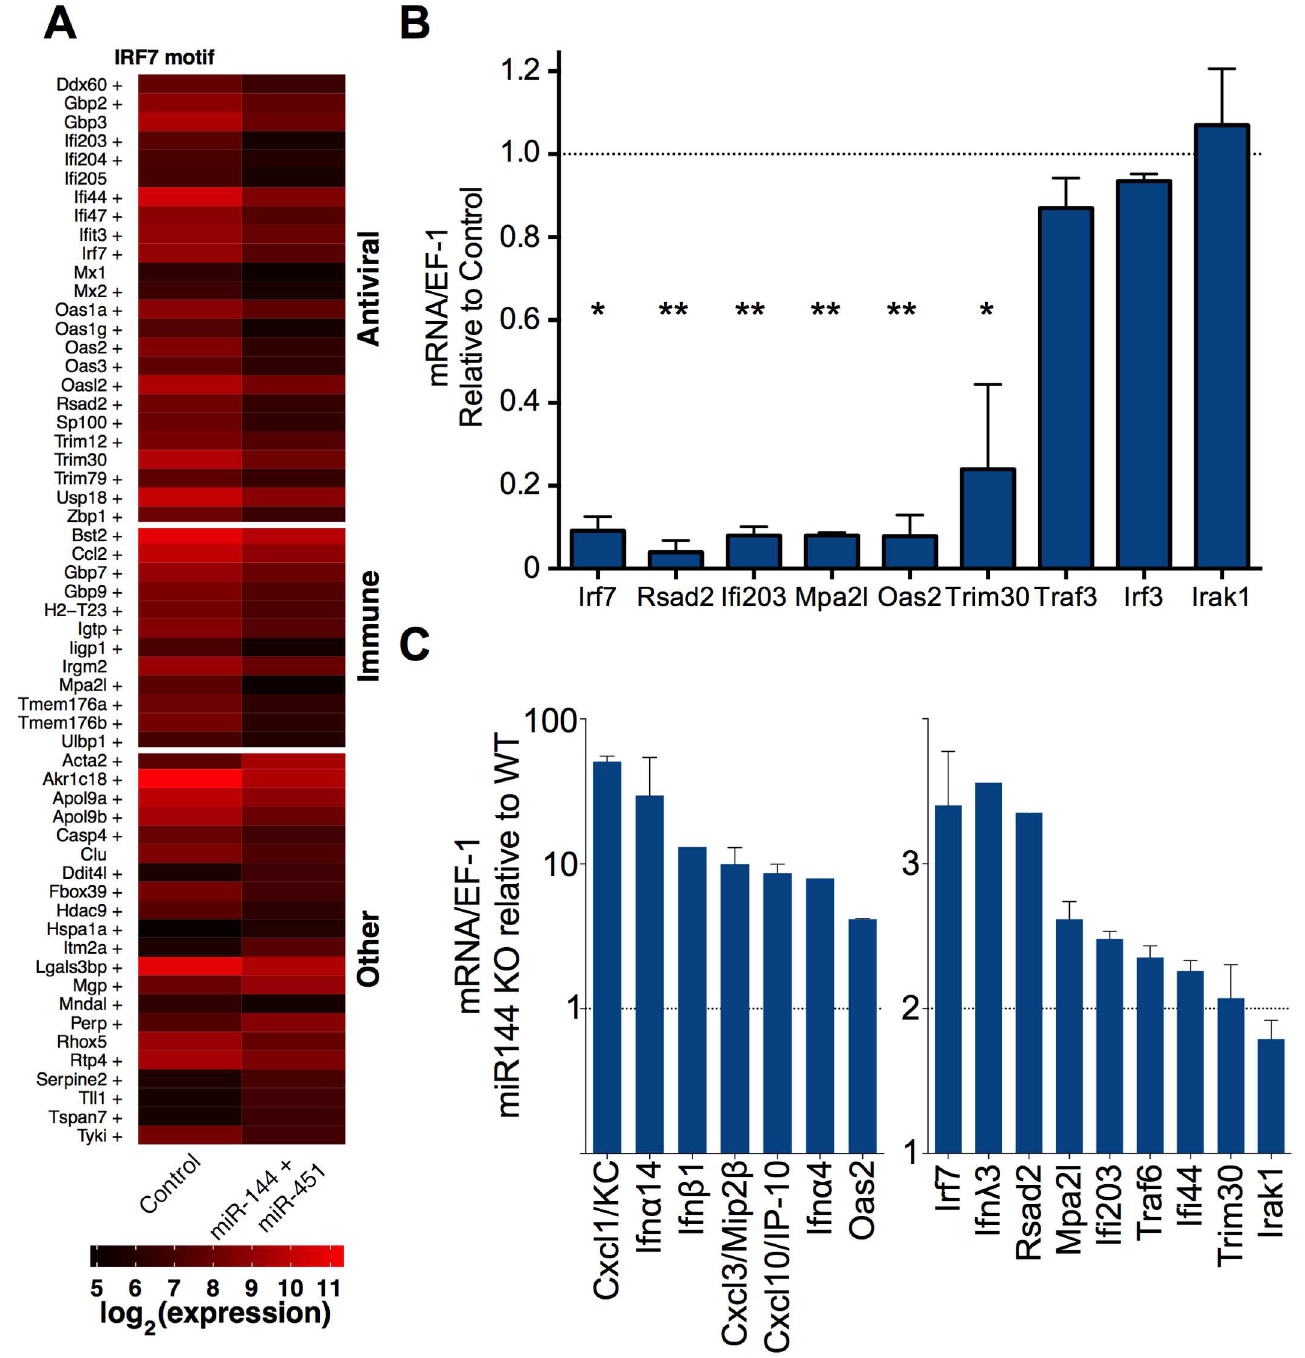
Fig 3. miR-144 attenuates the IRF7 transcriptional network. ( A ) Heat map depictingmicroarrayanalysisof influenza-infected TC-1 cells stably expressingmiR-144+miR-451 or vector alone, with genes groupedby functionalannotation. The indicatedgenes were differentiallyexpressed by > 2-foldafter 24 h relative to infected cells expressingvector aloneand clustered by biologicalfunction. Mean intensitiesfor 3 independent experiments are shown relative to uninfectedcontrol (vector alone)cells. Genes containing IRF7 motifs within 1 kB of the transcriptional start site are indicatedby “+”. ( B ) Expressionsof miR-regulated genes in influenza-infectedmiR-144+miR-451-expressing TC-1 cells (MOI = 5, 24 h) were measuredby qRT-PCR, normalized to EF-1, and plotted relativeto the levels in vector-onlycontrol cells. Means ± SEMfor 3 independent experiments are shown. ( C ) qRT-PCR was performed as describedin B on primary type I epithelialcells sorted from miR-144/451 null or WT littermates and infected with influenzavirus in vitro , n = 3. * p < 0.05, ** p < 0.01.